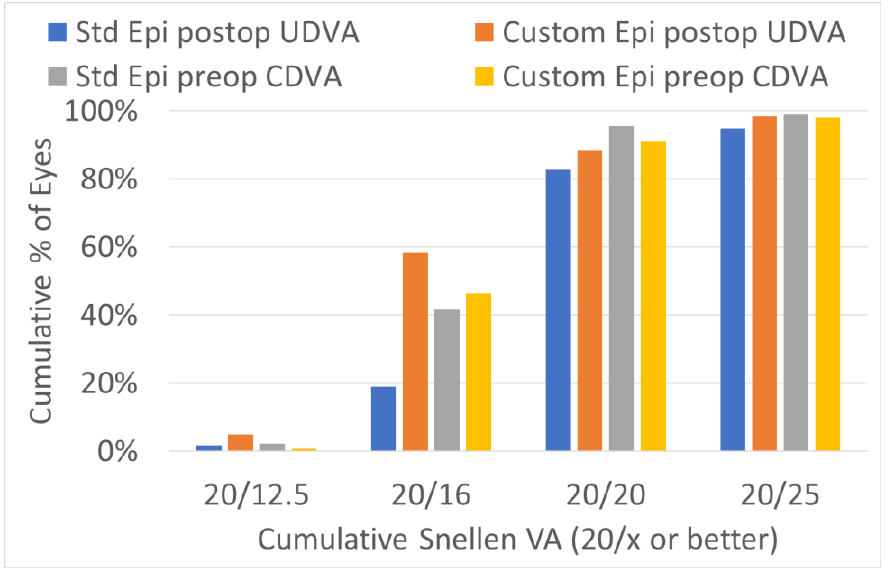
Figure 5. Efficacy of the preoperatively corrected distance visual acuity (CDVA) and the postoperatively uncorrected distance visual acuity (UDVA). The customized epithelium profile group contained more eyes, with a UDVA of 20/16 or better, postoperatively.